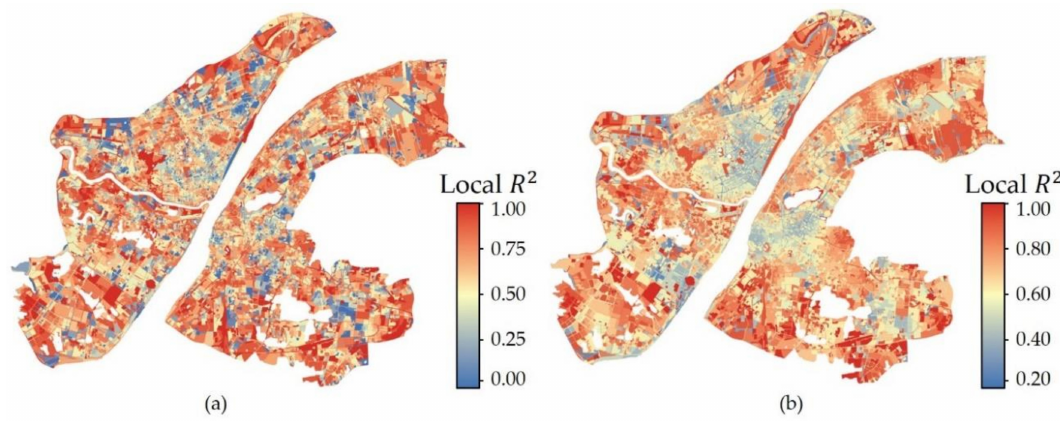
Figure 7. Local R 2 for two GWR models ( a ) SGWR ( b ) MGWR. Table 6. The slope coe ffi cients of the indicator to LST by MGWR,